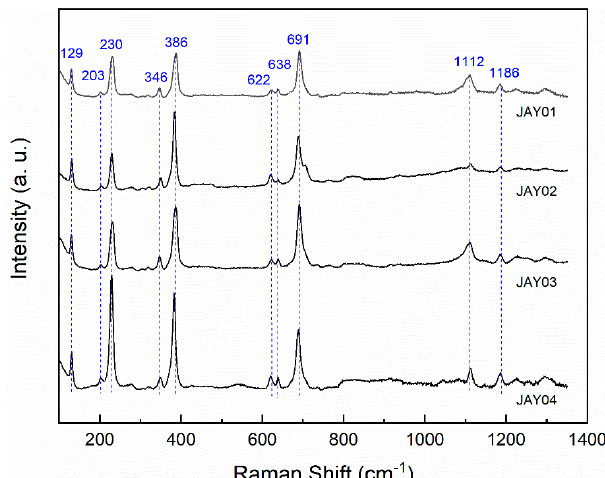
Figure 6. Typical Raman spectra of the large serpentines (antigorites) from jianite. Note that the Raman spectra from different samples (labeled with the text next to the spectrum) are almost identical. To illustrate clearly, only one Raman spectrum is shown for each sample, although multiple Raman spectra have been collected.